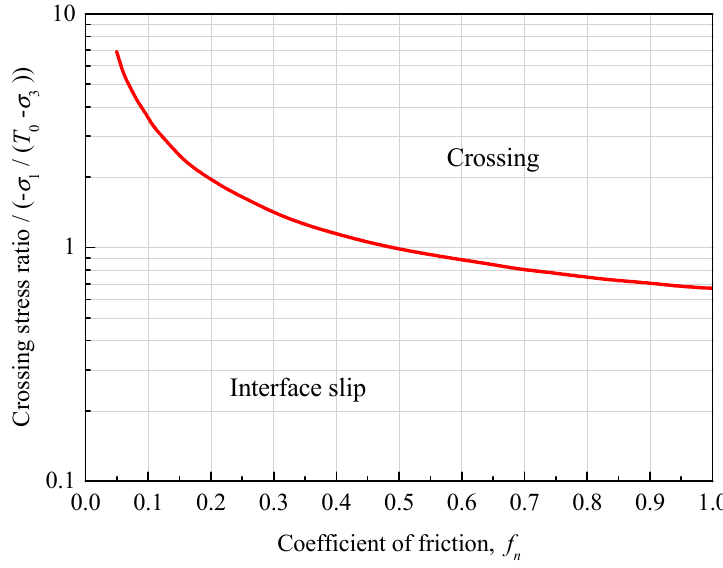
Figure 1. Coefficient of friction versus crossing stress ratio for orthogonal interfaces [14].